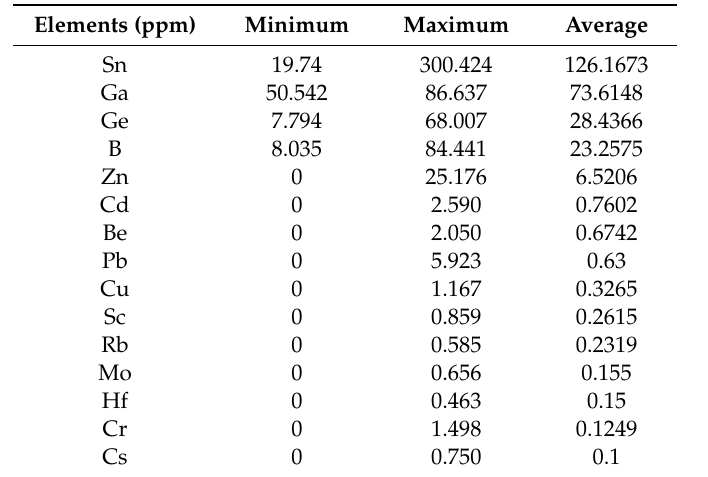
Table 2. Elemental concentration of the trace elements in ppm in the kunzite samples.